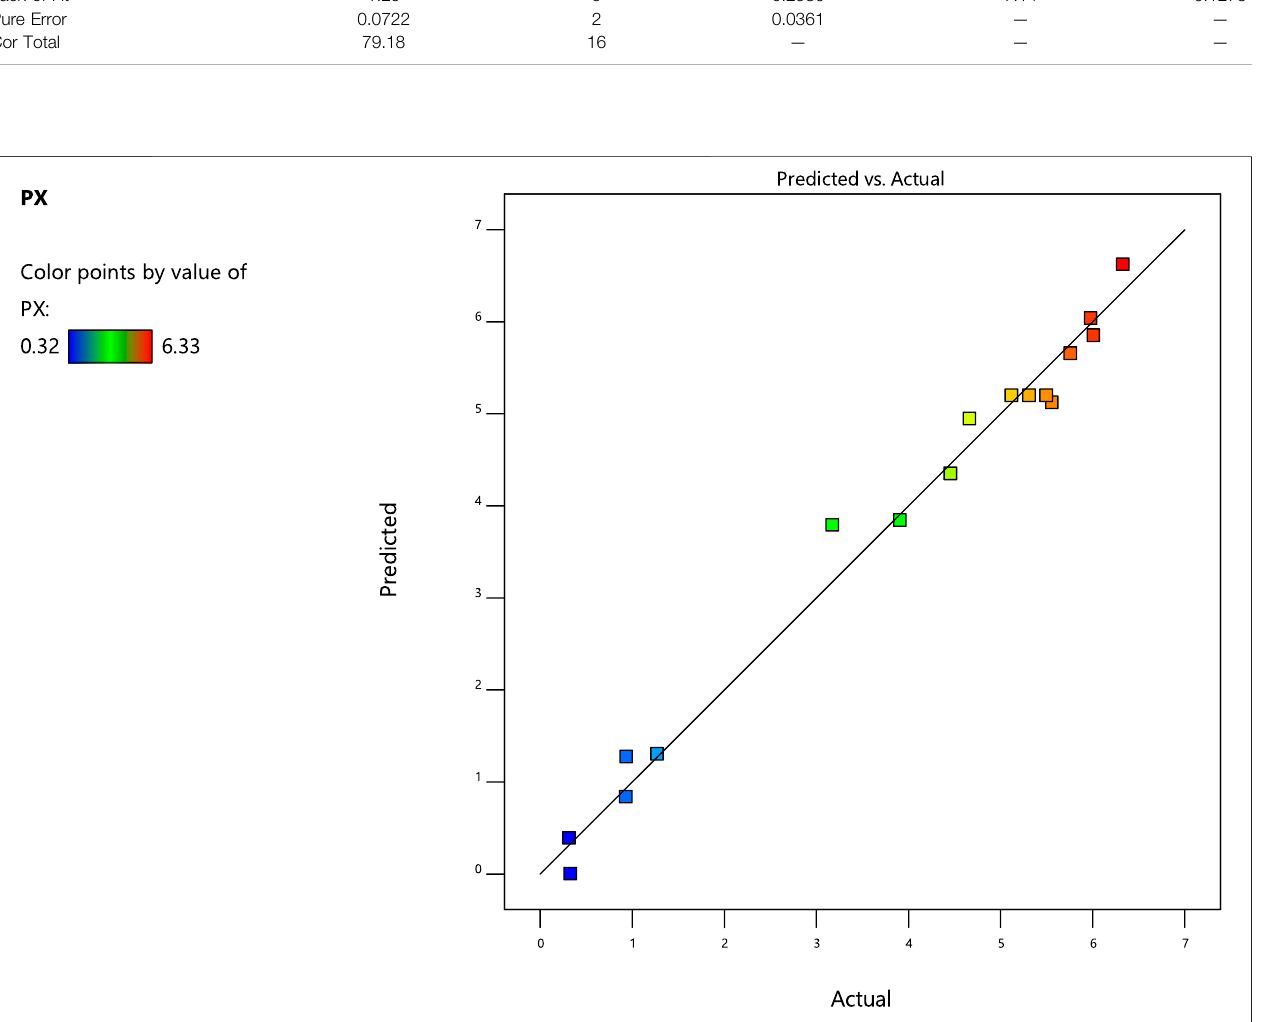
Frontiers in Bioengineering and Biotechnology |